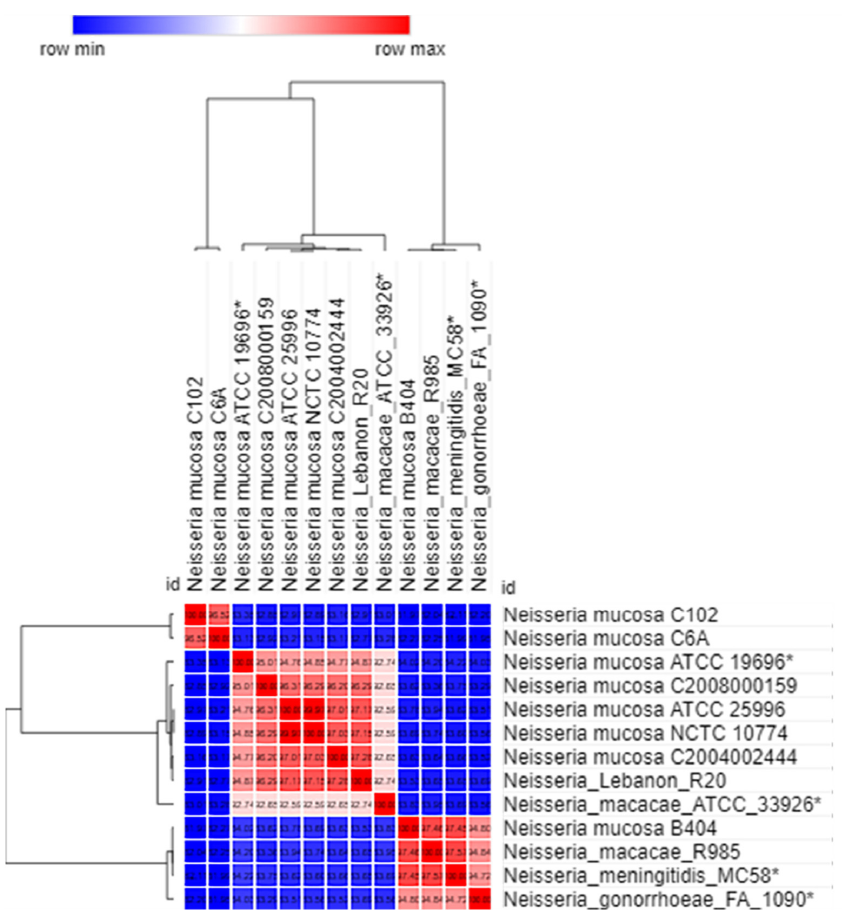
Figure 2. Functional heat-map of Neisseria mucosa and Neisseria macacae OrthoANI values. Reference genomes are marked by asterisk. Generation of the heatmap was done using Morpheus software (https://software.broadinstitute.org/morpheus/ (accessed on 2 November 2022)).